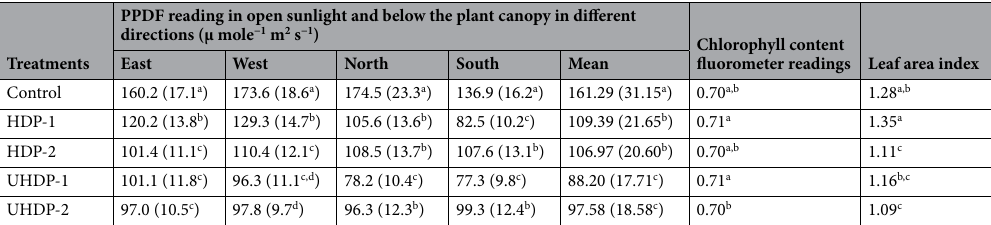
Table 2. Effect of planting density on PAR light intensity, leaf area index and leaf chlorophyll content (pooled data for 2015–16 to 2019–20). Avg. PPDF reading in open sunlight was 1250 µ mole −1 m 2 s −1 . Figures under parenthesis are transformed values. Means with at least one letter common are not statistically significant using TUKEY’s Honest Significant Difference at 5% Control: Planting at 6 m (row to row) × 6 m (plant to plant) spacing (tree density—277 plants ha −1 ), HDP-1: Planting at 6 m (row to row) × 3 m (plant to plant) spacing (tree density—555 plants ha −1 ), HDP-2: Planting at 4 m (row to row) × 4 m (plant to plant) spacing (tree density—625 plants ha −1 ), UHDP-1: Planting at 4 m (row to row) × 2 m (plant to plant) spacing (tree density—1250 plants ha −1 ), UHDP-2: Planting at 2 m (row to row) × 2 m (plant to plant) spacing (tree density—2500 plants ha −1 ).